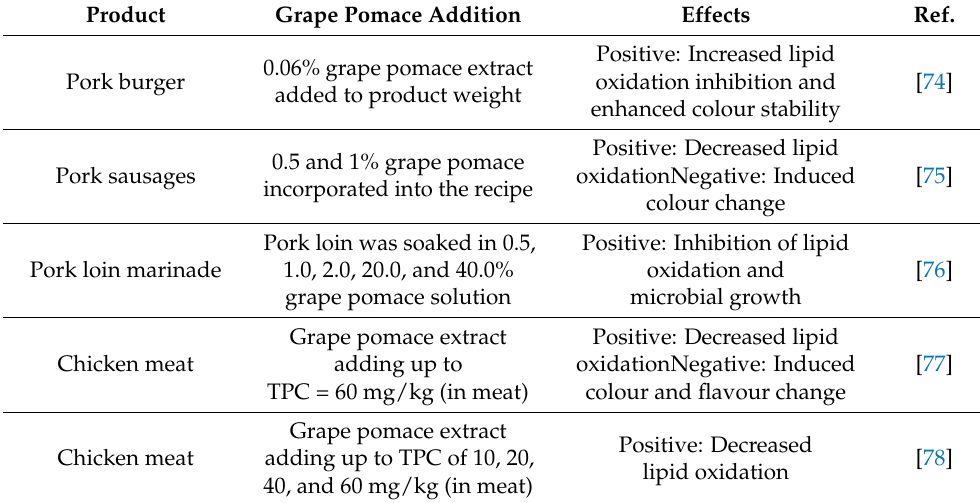
Table 4. Grape pomace effect on meat and